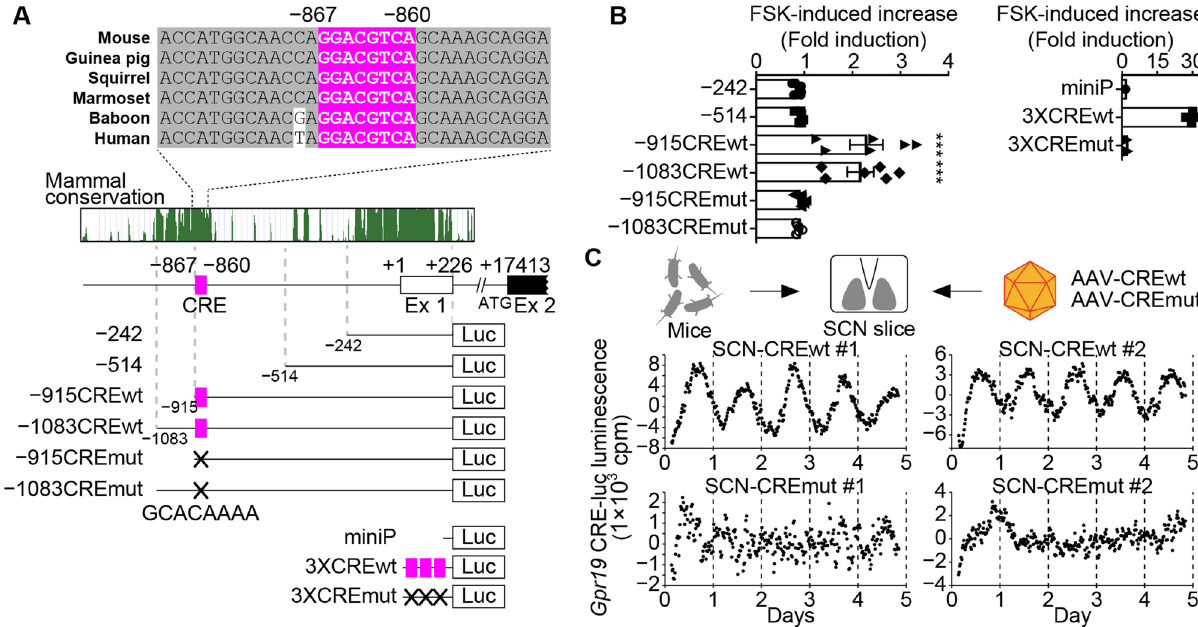
Figure 2. The Gpr19 CRE sequence has the ability to produce circadian transcription in the SCN. ( A ) The CRE in the Gpr19 promoter. Genomic positions relative to the transcription start site (+ 1) of the Gpr19 gene are indicated along with evolutionary conservation scores among mammalian species. Alignment shows the CRE (− 867 to − 860; highlighted in magenta) and its flanking sequences of mouse, human, and other representative mammalian species. We used reporter constructs containing serial deletions of the mouse Gpr19 promoter (− 242 to + 226, − 514 to + 226, − 915 to + 226, − 1083 to + 226) and the mutant derivative for the CRE (mut; GCA CAA AA). We also used reporter constructs containing 3 × isolated CRE (3 × CREwt) or its mutant (3 × CREmut). miniP, minimal promoter. ( B ) Gpr19 promoter activities in MEF cells after treatment with cAMP enhancer FSK. Average fold increase relative to basal activity was calculated ( n = 6, for each construct). Error bars indicate SEM. *** P < 0.001, one-way ANOVA, Bonferroni’s post hoc test. ( C ) Representative